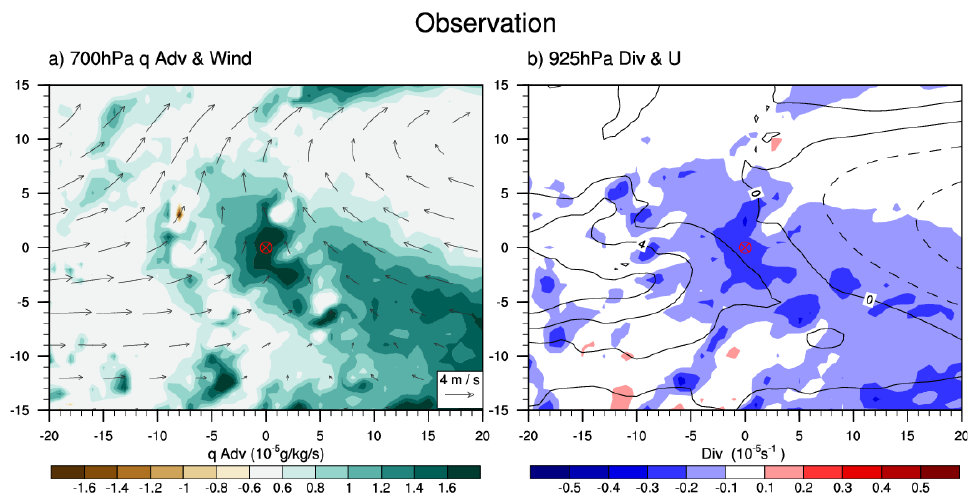
Figure 4. Composite horizontal patterns of ( a ) observed moisture advection (shading; 10 − 5 g/kg/s) and wind field (vector; ms − 1 ) at 700 hPa; ( b ) divergence (shading; 10 − 5 s − 1 ) and zonal wind (contour; ms − 1 ) at 925 hPa. The red circles (0, 0) represent the composite reference rainfall center. The composite is performed based on the eastward propagation stage from Pentad 1 – 4 to Pentad 9 – 12 .